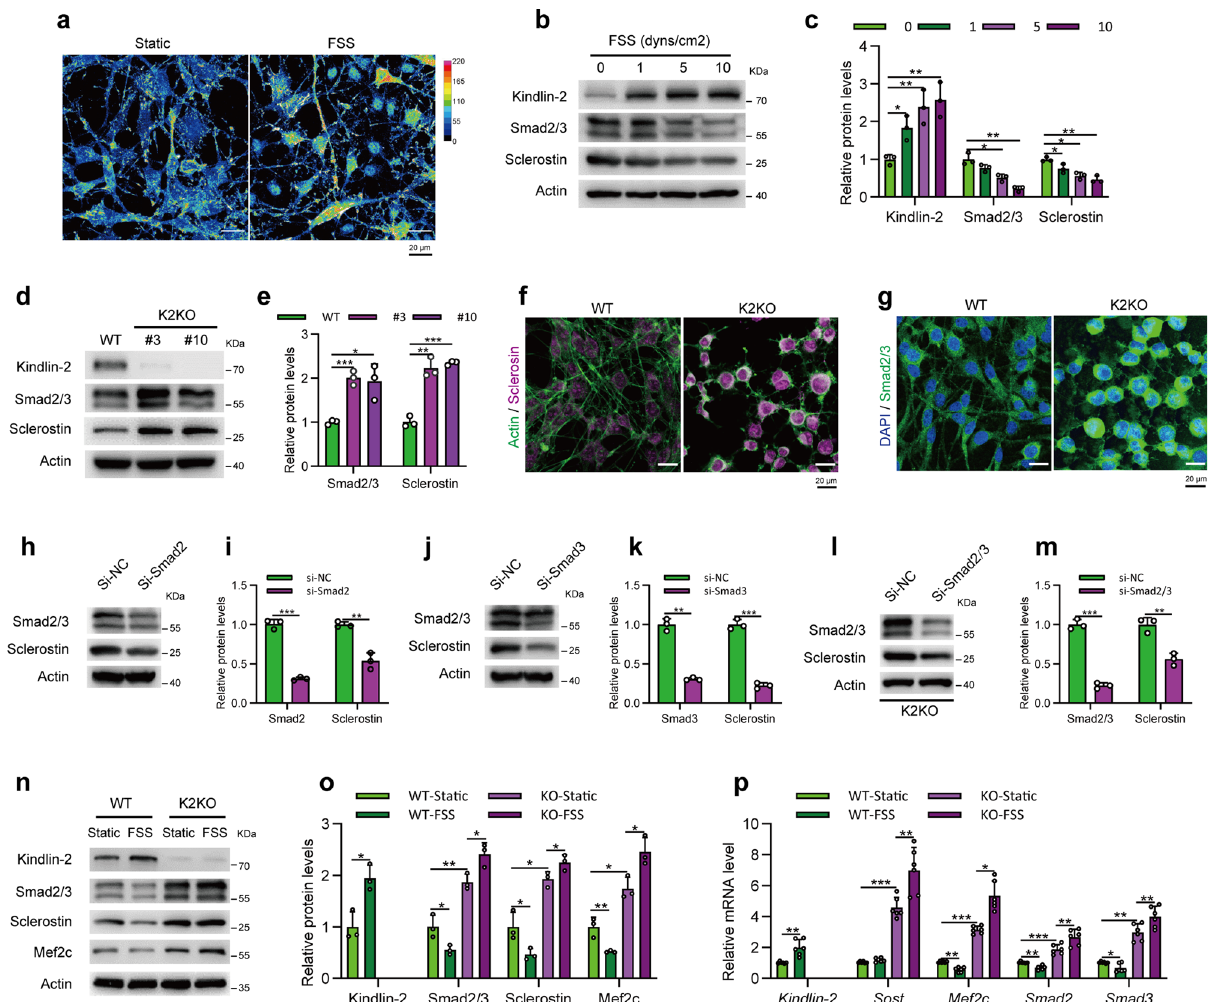
Fig. 5 Fluid shear stress (FSS) up-regulates Kindlin-2 and down-regulates Sclerostin and Smad2/3 expression in a dose-dependent manner in MLO- Y4 cells. a Heat-map images of Kindlin-2 expression in WT MLO-Y4 cells at static or FSS conditions. b Protein levels of Kindlin-2, Smad2/3, Sclerostin, and β -Actin detected with western blotting in WT MLO-Y4 cells under 0, 1, 5, and 10 dyns/cm 2 FSS treatment. c Quanti fi cation of protein levels of Kindlin-2, Smad2/3 and Sclerostin relative to that of β -Actin (as a loading control) in b . d The protein expression of Kindlin-2, Smad2/3 and Sclerostin was analyzed by western blotting in WT and two K2KO (#3, #10) MLO-Y4 cells. β -Actin served as a loading control. e Protein levels of Kindlin-2, Smad2/3 and Sclerostin relative to that of β -Actin in WT and K2KO cells were quanti fi ed by densitometric analysis of western blotting. f Merged immuno fl uorescence images of Sclerostin (magenta) and F-actin (green) in WT and K2KO MLO-Y4 cells. g Merged immuno fl uorescence images of Smad2/3 (green) and DAPI (blue) in WT and K2KO MLO-Y4 cells. WT MLO-Y4 cells were transfected with control (si-NC) or Smad2 siRNA ( h , i ), or Smad3 siRNA ( j , k ) for 48 hours and then analyzed by western blotting with antibodies against Smad2/3, Sclerostin and β -Actin (as a loading control). K2KO MLO-Y4 cells were transfected with control (si-NC) or double Smad2/3 siRNA (si-Smad2/3) for 48 h and then analyzed by western blotting ( l , m ) with antibodies against Smad2/3, Sclerostin and β -Actin (as a loading control). n Protein levels of Kindlin-2, Smad2/3, Sclerostin, Mef2c, and β -Actin detected with western blotting in WT and K2KO MLO-Y4 cells under static or 10 dyns/cm 2 loading conditions, and quanti fi ed in o . p The transcription levels of Kindlin-2, Smad2, Smad3, Mef2c, and Sclerostin mRNA were detected through quantitative PCR analysis in WT and K2KO cells under static and FSS conditions. Quantitative results from at least three independent experiments. * P < 0.05, ** P < 0.01, *** P < 0.001, versus controls, Student ’ s t test. Results are expressed as mean ± standard deviation (Fig. 5e). Similar increases in the expression of Smad2/3 and Sclerostin were observed in the K2KO cells through IF staining (Fig. 5f, g). These data suggest that Kindlin-2 may function as a suppressor of Smad2/3 and Sclerostin expression in MLO-Y4 cells. A previous study by Loots and coworkers has shown that Smad2/3 transcriptionally activates the expression of Sclerostin in osteoblasts 73 . We found that siRNA knock down of Smad2, Smad3, or both (Smad2/3) dramatically reduced the level of Sclerostin protein in MLO-Y4 cells (Fig. 5h – m). Together, these results suggest that Kindlin-2 suppresses Sclerostin expression in MLO-Y4 cells probably through its suppression of Smad2/3.